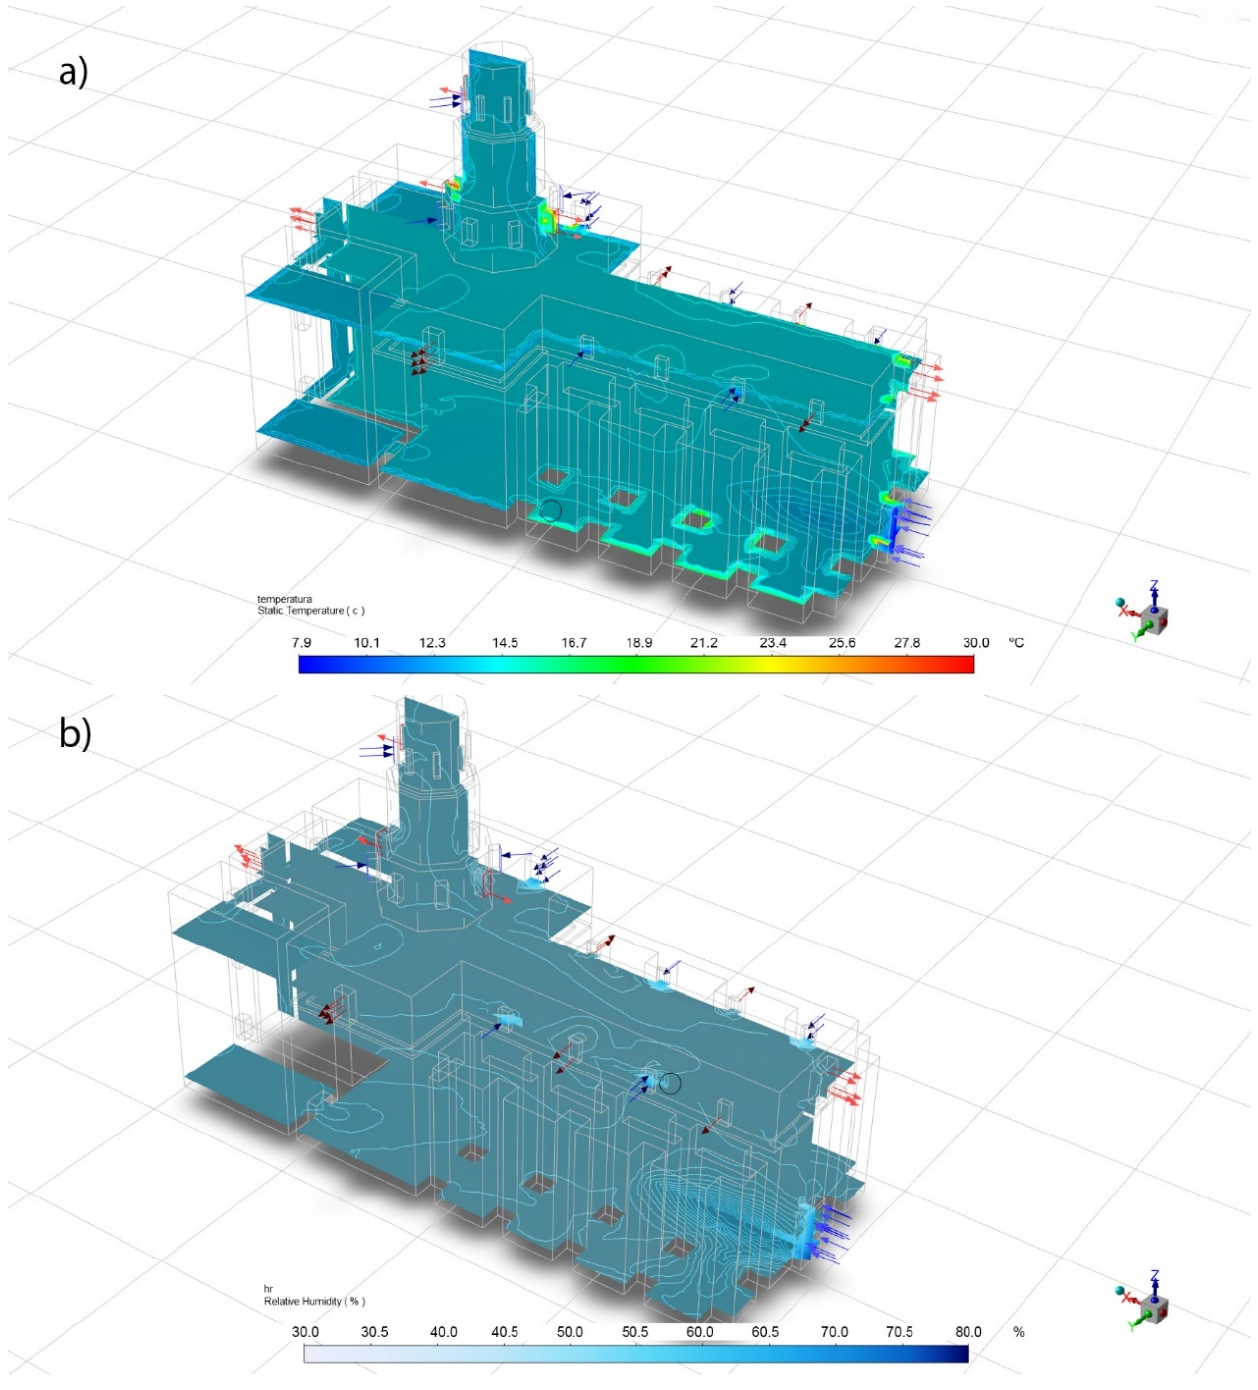
Figure 7. Winter CFD simulation perspective. ( a ) Temperatures and ( b ) relative humidity.